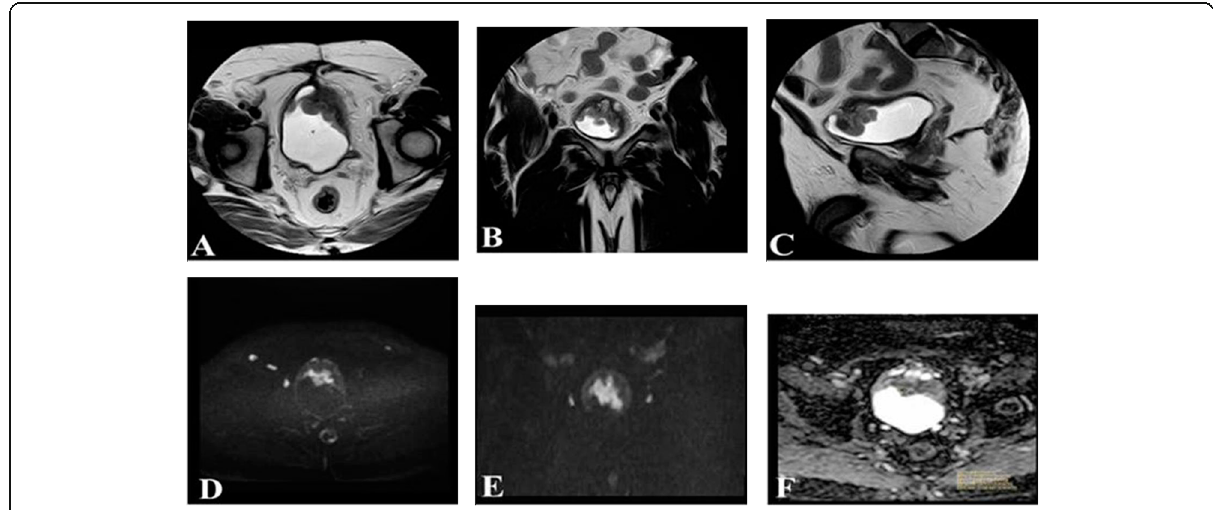
Fig. 3 An intravesical soft tissue mass is seen arising from anterior wall with infiltration of the muscle layer. a Axial HR T2 image, b coronal HR T2 image, c sagittal HR T2 image, d axial DWI (b 1400) image, e coronal DWI image (b 1400), and f axial ADC map with ADC measured within lesion (0.62 × 10 − 3 mm2/s). Pathologically proved urothelial carcinoma, T2,